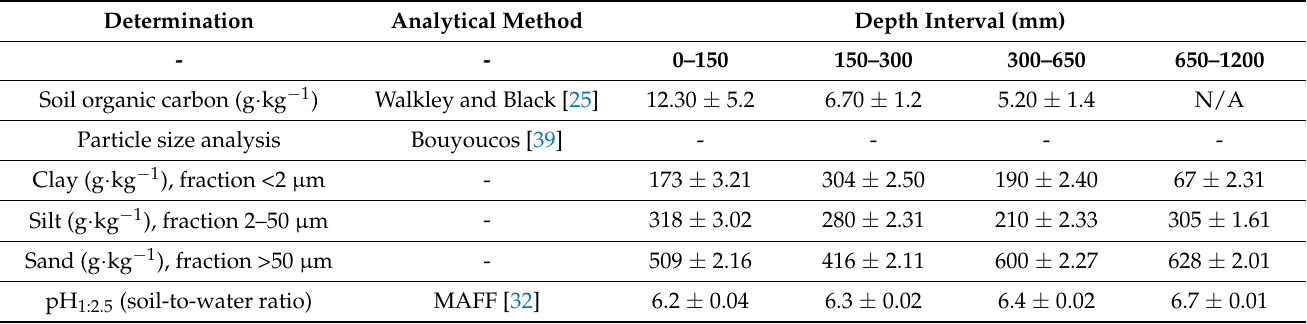
Table 2. Soil profile characterization for the Entic Hapludoll at the study site (N/A: data not available). Values are means ± SD.